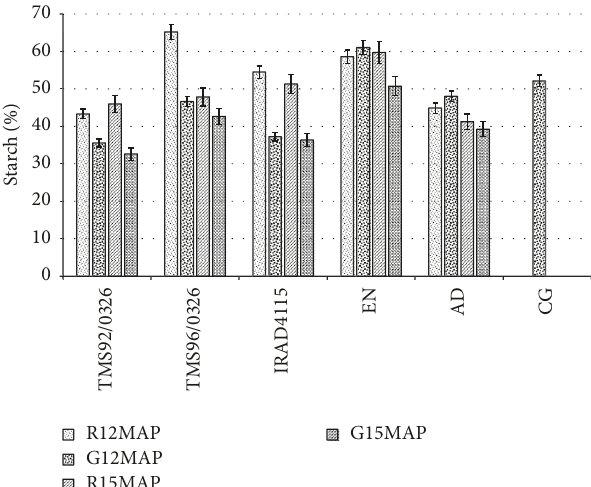
Figure 3: Effect of the harvest period (12 and 15 months after planting) on the starch content (g/100g of dry weight) of cassava gari. Garis are produced from local ( EN and AD ) and improved ( TMS92/0326, TMS96/1414, and IRAD4115 ) cassava varieties root harvested in dry season at 12 months and in rainy season at 15 months after planting (12MAP and 15MAP). These garis were compared to the commercial cassava gari (CG). G = gari and R = fresh